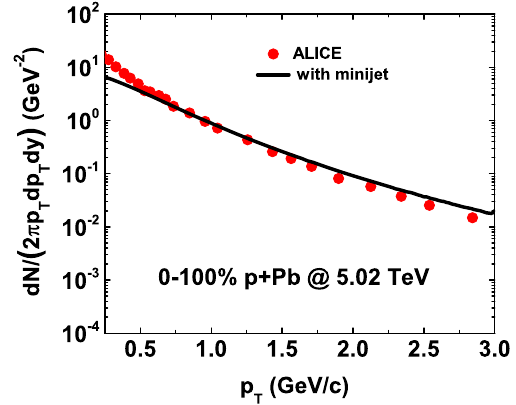
Fig. 10 Charged hadron spectra at midrapidity in center of mass frame inminimum-bias5.02TeVp+Pbcollisionswiththeinclusionofminijet at p T > 3 GeV / c compared to data from the ALICE Collaboration [47]